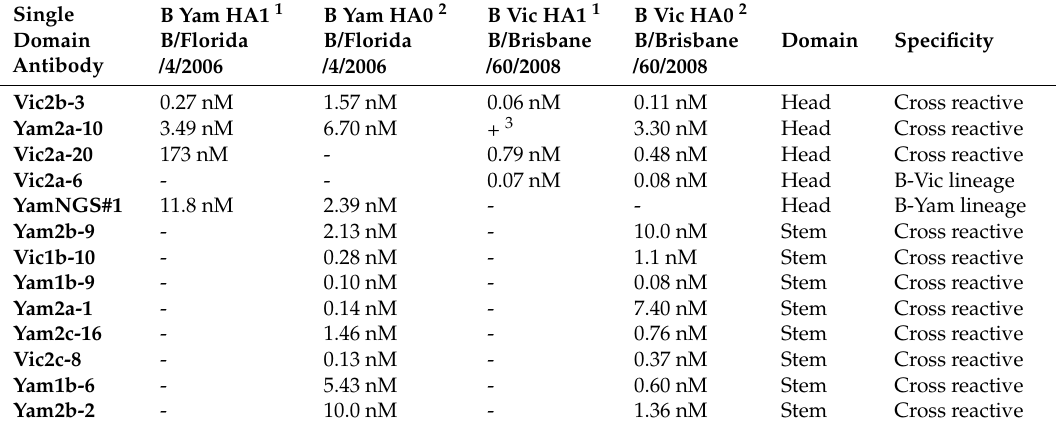
Table 3. Epitope classification of full-length (HA0) and head domain (HA1) using surface plasmon resonance